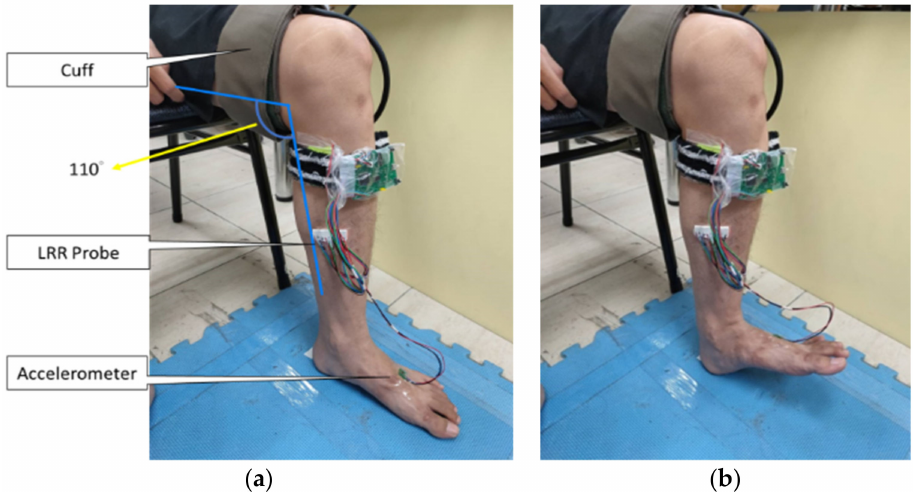
Figure 8. Real photo of LRR measurement: ( a ) placement of the cuff, LRR probe, and accelerometer, ( b ) the foot